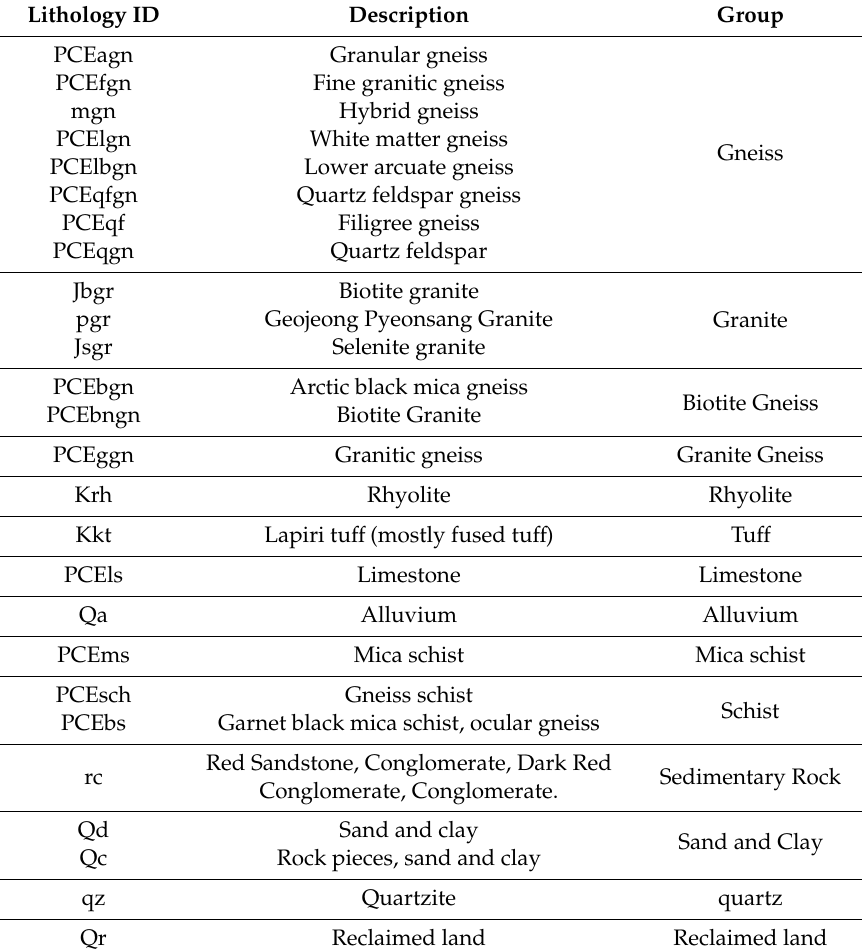
Table 4. Description of the lithological units in the study